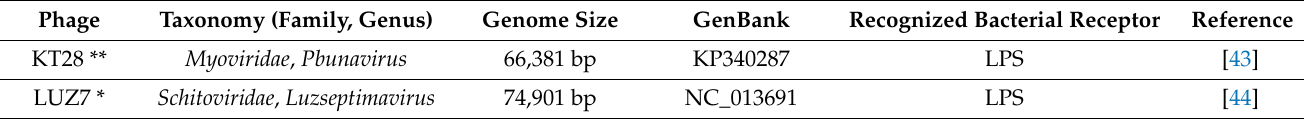
Table 1. Characteristics of phages used in this